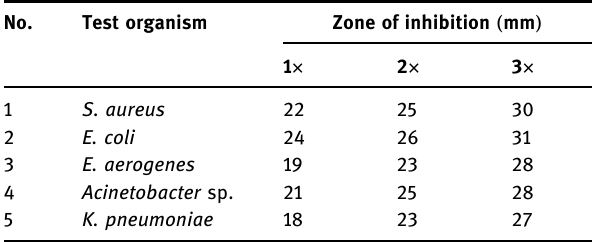
Table 5: Zone of inhibition of EHC against test organisms No. Test organism